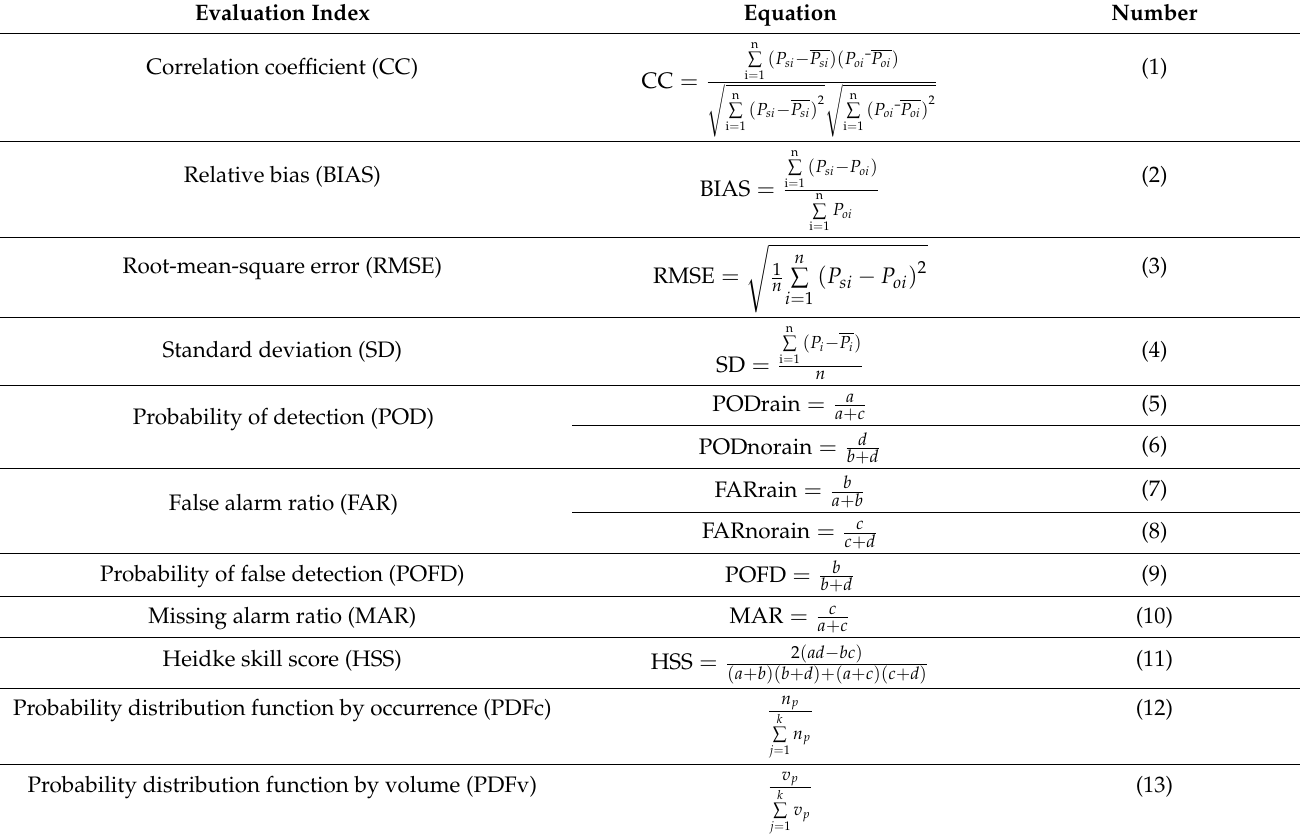
Table 1. Evaluation indexes for remote sensing precipitation